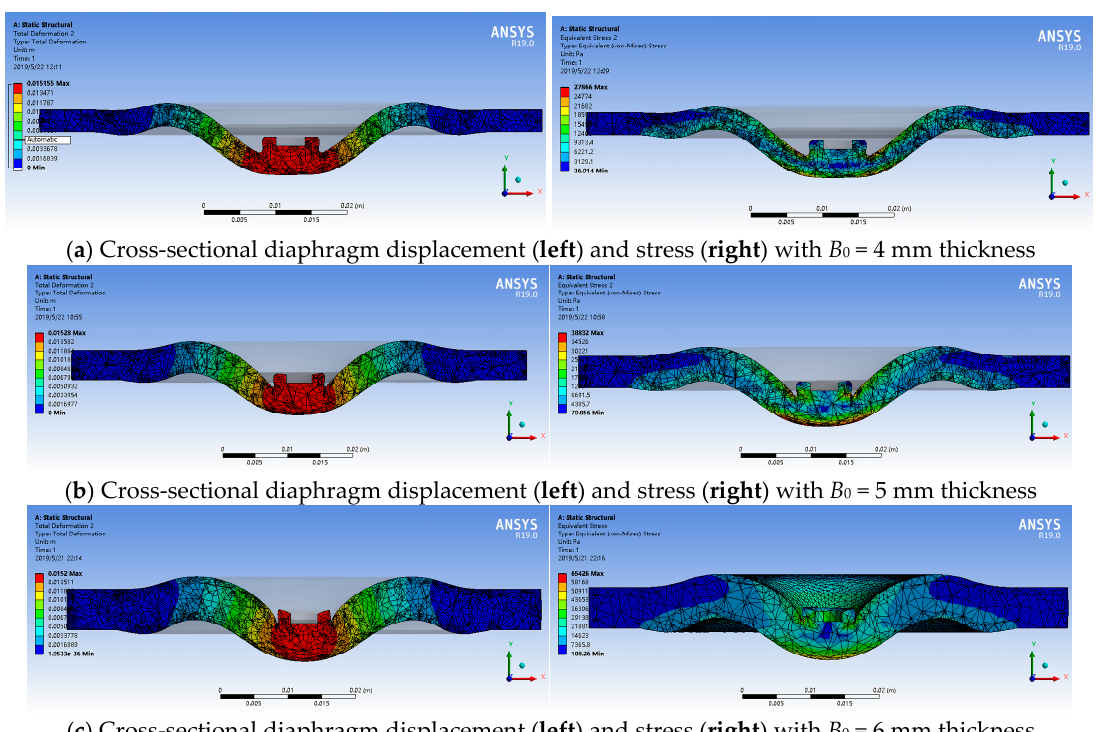
Figure 3. Displacement Diagram and Stress Diagram of Diaphragms with Different Thicknesses.